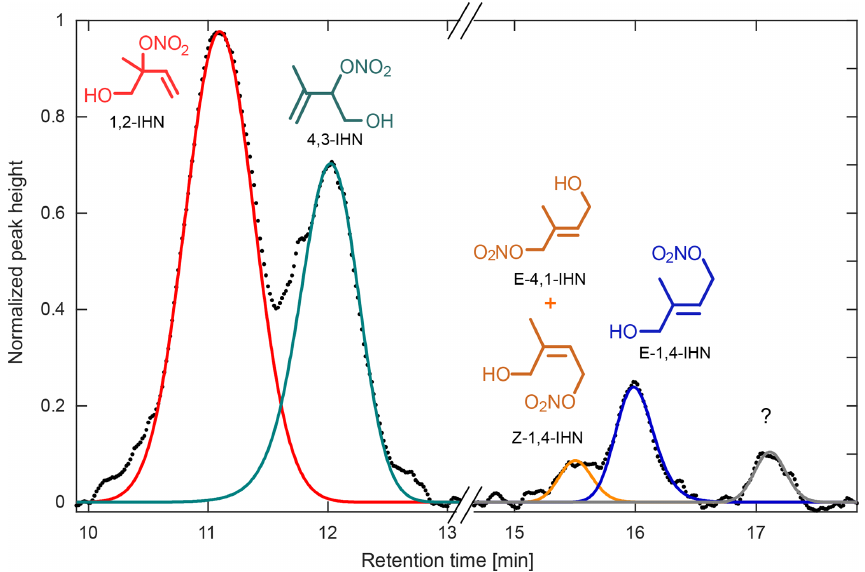
Figure 11. Chromatogram obtained during the Caltech field study for m/z 232, attributed to the IHN isomers, normalized to the largest peak height. At least four isomers of IHN were observed: 1,2-IHN (red), 4,3-IHN (green), E -4,1- and Z -1,4-IHN (coelute, orange), and E -1,4-IHN (blue). Z -4,1-IHN was not present above the instrument detection limit. An unidentified component, which likely corresponds to a species observed in laboratory isoprene oxidation studies, is present near the end of the chromatogram (gray; see Teng et al., 2017).